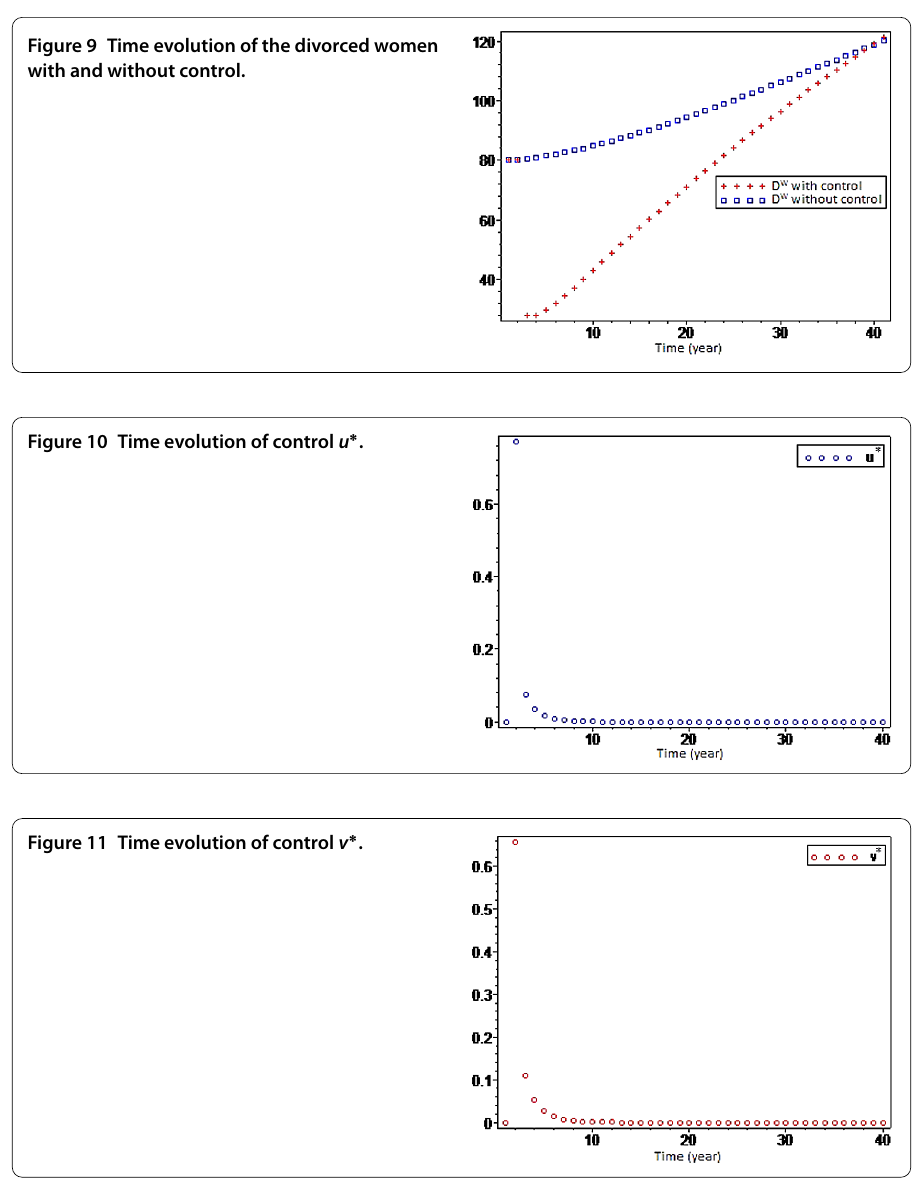
Figure 9 Time evolution of the divorced women with and without control.